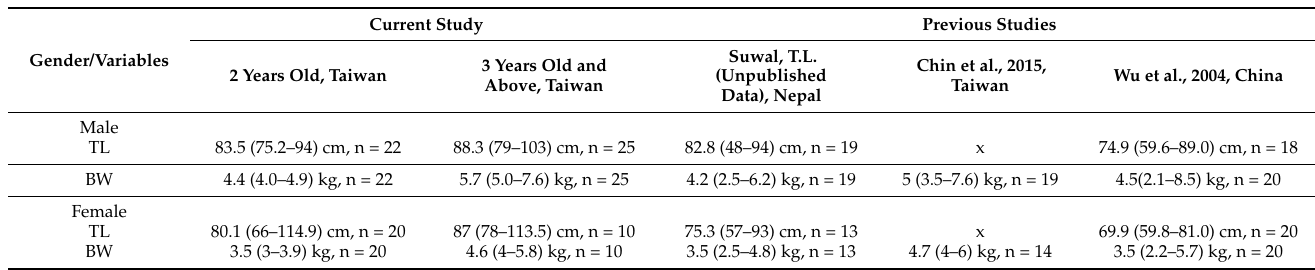
Table 4. The average total length (TL) and bodyweight (BW) and of adult (2 years old and above) Chinese